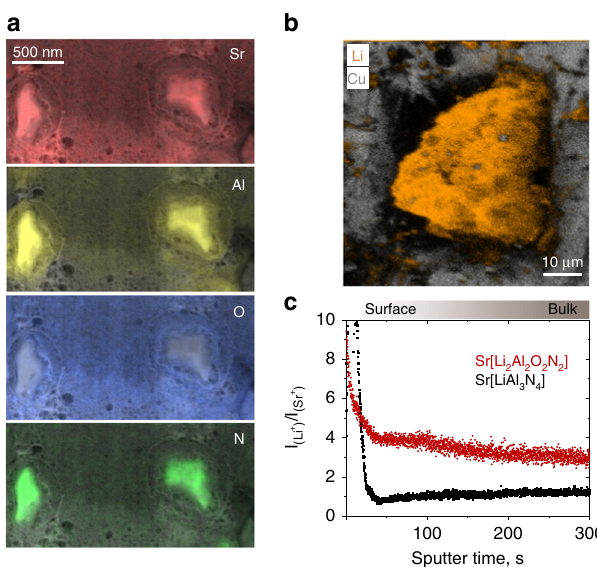
Fig. 2 Scanning transmission electron microscopy combined with energy- dispersive X-ray spectroscopy (STEM/EDX) and time of fl ight secondary ion mass spectrometry (ToF-SIMS) analyses of SALON. a Qualitative false- colour representation of the lateral distribution of the elements Sr, Al, O, and N. b Qualitative false-colour representation of the lateral distribution of the elements Li and Cu for a Sr[Li 2 Al 2 O 2 N 2 ]:Eu 2 + phosphor particle that has been placed into a pocket of a copper transmission electron microscopy grid with 50 µ m mesh width. c Time of fl ight mass spectrometry depth pro fi le of the Li + secondary ions signal intensities in Sr[LiAl 3 N 4 ] and Sr [Li 2 Al 2 O 2 N 2 ], divided by the respective signal intensities of the Sr + secondary ions. Below the particle surface, the normalized signal intensities approach a linear level (further details are provided in the Method